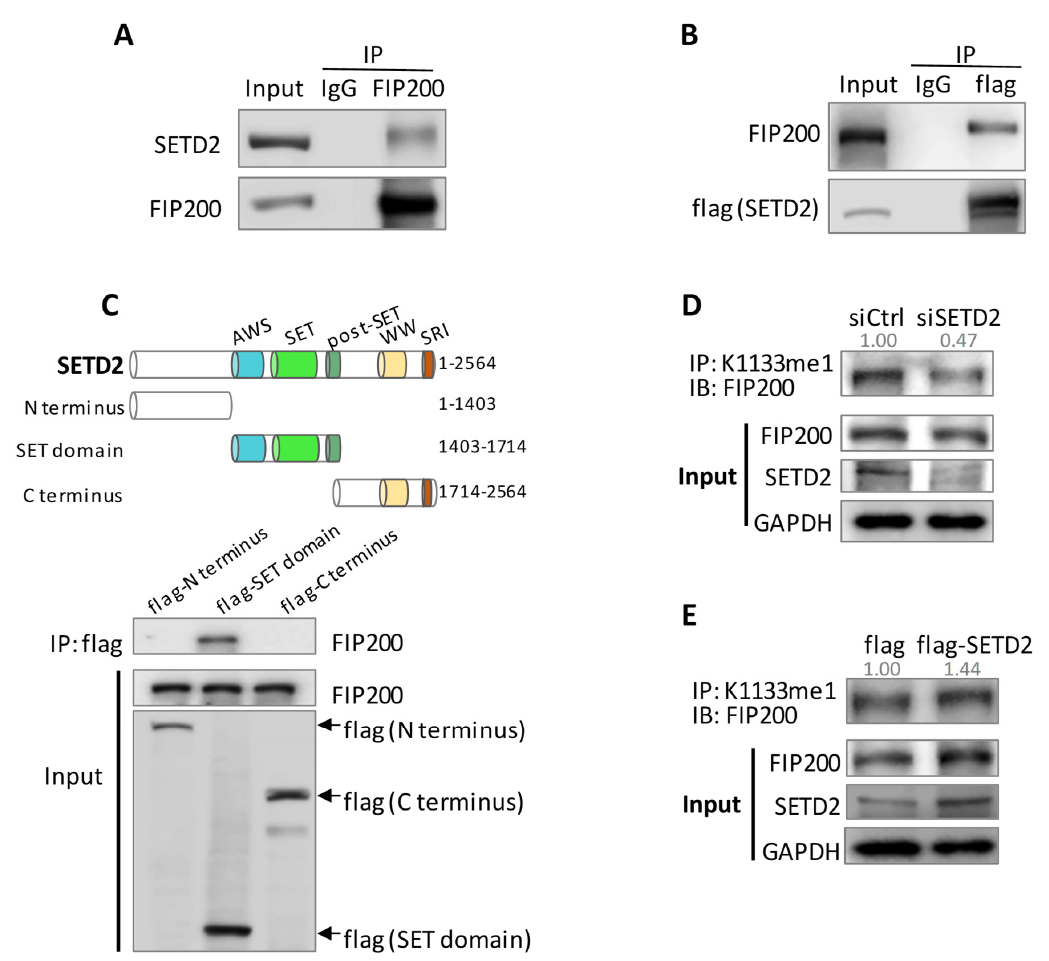
Figure 2 . SETD2 binds and methylates FIP200. ( A ) Co-IP assay showed that SETD2 binds to FIP200. HEK 293 cell lysate was pulled down using an anti-FIP200 Ab. SETD2 was detected by immunoblot. ( B ) Co-IP assay showed the interaction between flag- SETD2 and FIP200. Flag-SETD2 was overexpressed in HEK293 cells and pulled down using an anti-flag Ab. FIP200 was detected by immunoblot using anti-FIP200 Ab. ( C ) SETD2 SET domain bound to FIP200. SETD2 protein structure and functional domains were summarized in the schematic graph. Flag-tagged SETD2 fragments were overexpressed in HEK293, pulled down by an anti-flag Ab. FIP200 immunoblot indicated the SET domain, but not the N-terminus and C terminus bound to FIP200. ( D-E ) Pulldown assay showed that FIP200 K1133me1 level was positively correlated to the SETD2 level. HEK293 cells were transfected with siSETD2 ( D ) or flag-SETD2 ( E ). Pulldown assay showed decreased and increased FIP200 K1133me1 after SETD2 knockdown and overexpression, respectively. Immunoblot was quantified and normalized to the